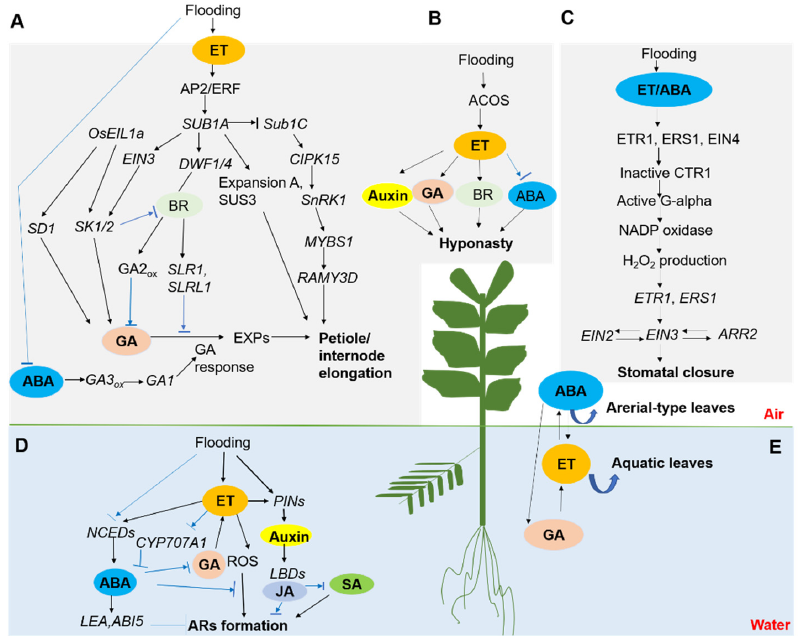
Figure 1. A schematic model of plants’ morphological adaptations during flooding stress (adapted from [17,33,68–74]). To cope with flooding stress, plants undergo multifaceted anatomical, metabolic, and morphologic alterations. The morphological adaptations include shoot elongation ( A ), hyponasty ( B ), stomatal closure ( C ), adventitious roots formation ( D ), and heterophylly induction ( E ). The model is collective and integrates findings reported in one or more species. The interactions and hierarchy of signaling components can vary depending on species. ( A ): Processes, hormones, and genes involved in submergence-induced shoot elongation (blue arrows indicate an inhibitory effect). Submergence causes accumulation of ethylene, and subsequently, it induces reduction of ABA biosynthesis and promotes the ABA catabolism, which leads to a lower endogenous ABA concentration in rice. This stimulates GA signaling and ultimately enhances petiole elongation. BR is also involved in this process. ( B ): Increased ethylene biosynthesis in waterlogged Arabidopsis is linked to transcript accumulation of ACO5. GA, BR, auxin, and ABA positively regulate the hyponasty, while the accumulation of ABA was inhibited by ethylene. ( C ): A proposed model for the hormone-mediated stomatal closure under waterlogging stress. Ethylene and/or ABA directly or indirectly enhance H 2 O 2 production under waterlogging conditions. The binding of ethylene to ETR1, ERS1, and EIN4 induced the inactivation of CTR1, resulting in the activation of G alpha, which promotes H 2 O 2 production via NADPH oxidases. ETR1 and ERS1 translocate the signals of H 2 O 2 to EIN2, EIN3, and ARR2, which are essential for stomatal closure functioning. ( D ): Adventitious root biogenesis and growth regulation in plants. Ethylene, which accumulates in submerged tissues, promotes adventitious root growth. GA enhances ethylene-induced root growth, while ABA acts as a root growth inhibitor. ROS act downstream of ethylene to mediate the root growth response. Auxin also promotes adventitious root biogenesis. ( E ): In aquatic plants, ABA could initiate and maintain the development of aerial-type leaves, and this process is dependent on the cross-talk with ethylene- and GA-signaling pathways, which initiate and maintain the formation of submerse leaves. Abbreviations—AP2/ERF: apelata2/ethylene response